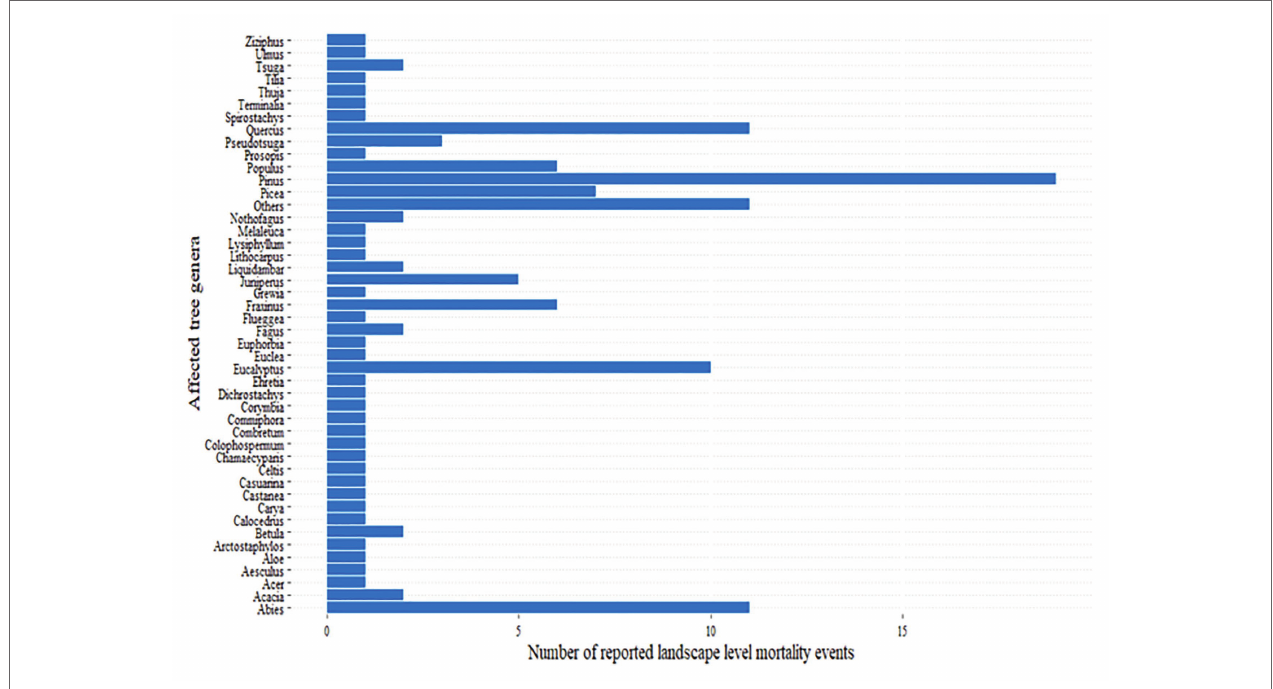
FIGURE 4 | The main genera of trees affected by landscape level tree mortality events across the world ( Figure 1 ; Supplementary Table 2